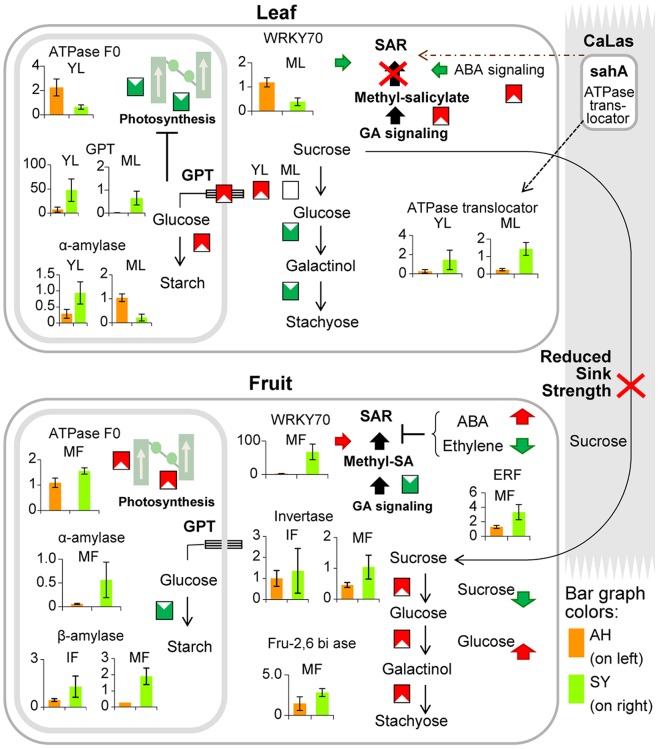
Transcriptional regulation of fruit and leaf metabolism and sugar transport during HLB disease.qRT-PCR data compared AH and SY tissues. White triangles within filled squares indicate up- and down-regulated genes. Arrows pointing up and down likewise indicate increased and decreased metabolite concentration. In each bar graph, AH appears on the right, and SY on the left, where vertical axis units are relative ratios of the test gene and housekeeping gene abundance.